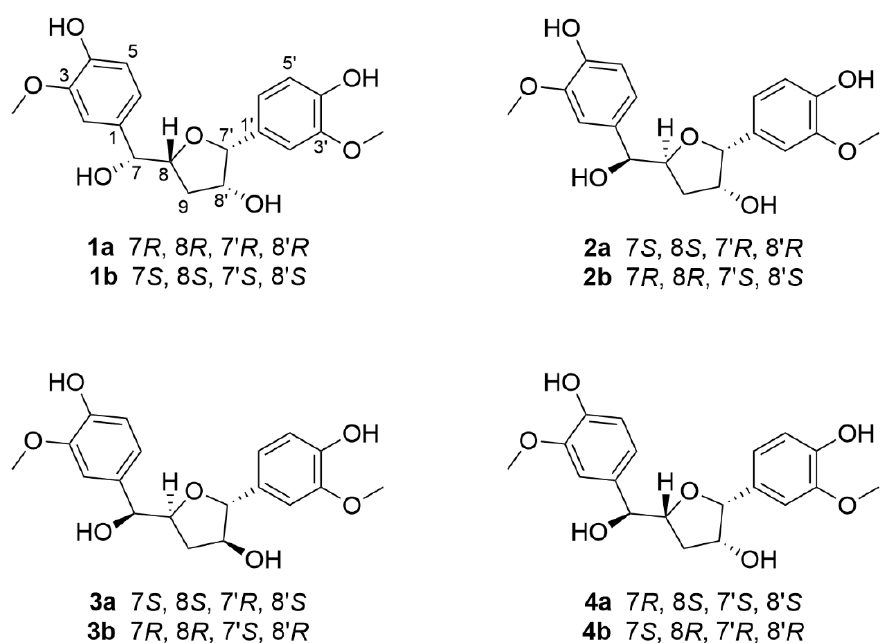
Figure 1. The structures of compounds 1 – 4 from F. sinkiangensis